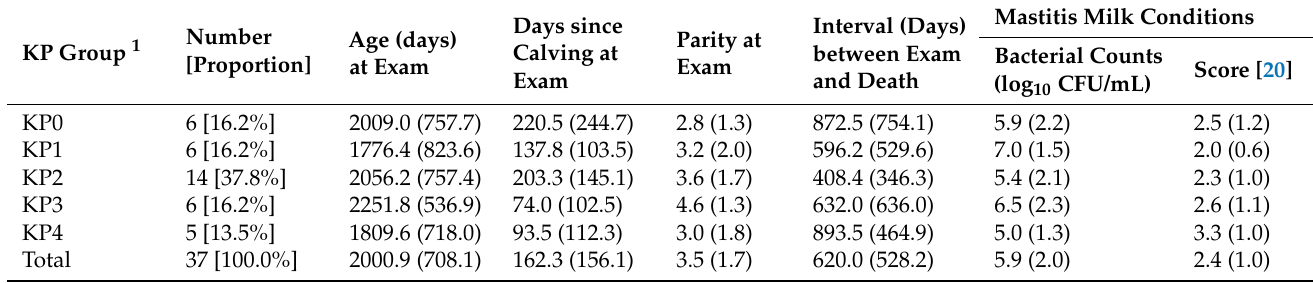
Table 1. Comparison of clinical data [mean (standard deviation)] in mastitis cases, and mastitis milk conditions associated with polymerase-chain-reaction (PCR)-positive numbers of iron-acquisition genes in Klebsiella pneumoniae